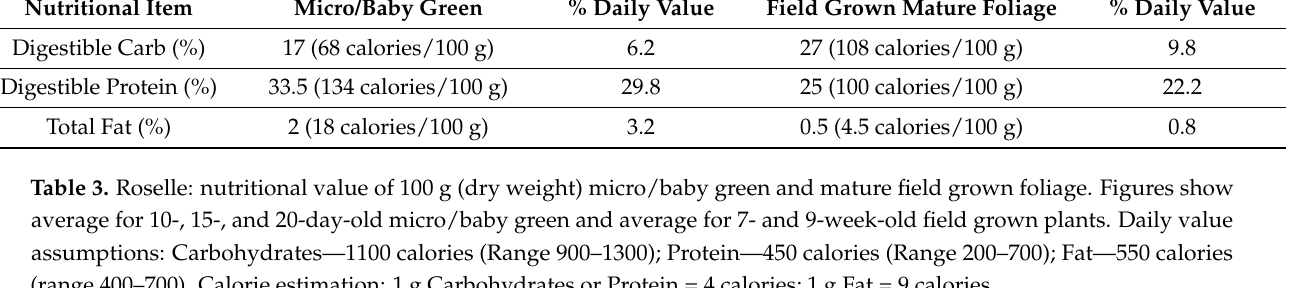
Table 2. Tropical spinach: nutritional value of 100 g (dry weight) micro/baby green and mature field grown foliage. Figures show average for 10-, 15-, and 20-day-old micro/baby greens and average for 5- and 7-week-old field grown plants. Daily value assumptions: Carbohydrates—1100 calories (Range 900–1300); Protein—450 calories (Range 200–700);